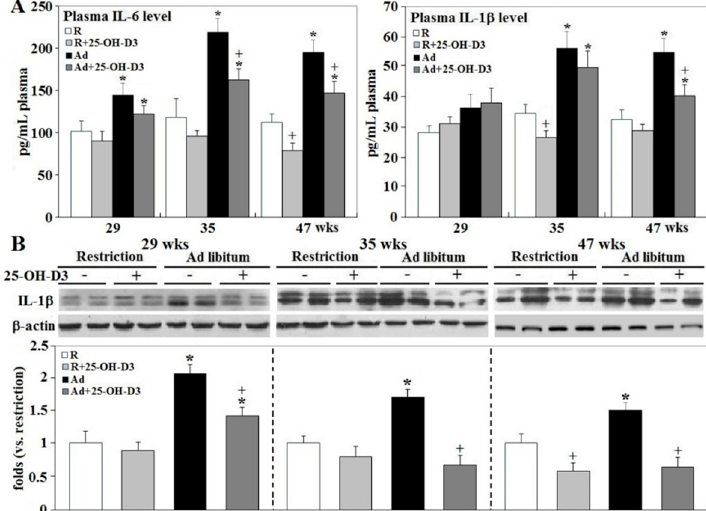
Figure 1. Effects of dietary 25-hydroxycholecalciferol (25-OH-D 3 ) supplementation on systemic and cardiac inflammation of broiler breeder hens provided with restricted or ad libitum feed intake. Plasma IL-6 and IL-1 β concentration were determined by ELISA method ( n = 4, 7, 7 for each group at 29, 35, and 47 wks, respectively, panel ( A ). Four hearts from collections at 29, 35, and 47 wks were used for cardiac IL-1 β analysis by Western blot (n = 4 for each group, panel ( B ). Densitometric intensities of Western blot were normalized to β -actin and expressed as ratios relative to R-hens at 29, 35, or 47 wks. *; significant difference by Ad-feed intake ( vs . corresponding R hens, p < 0.05). +; significant difference by 25-OH-D 3 (vs. R or Ad hens, p < 0.05). R; restriction, Ad; ad libitum, 25-OH-D 3 : 25-hydroxycholecalciferol.